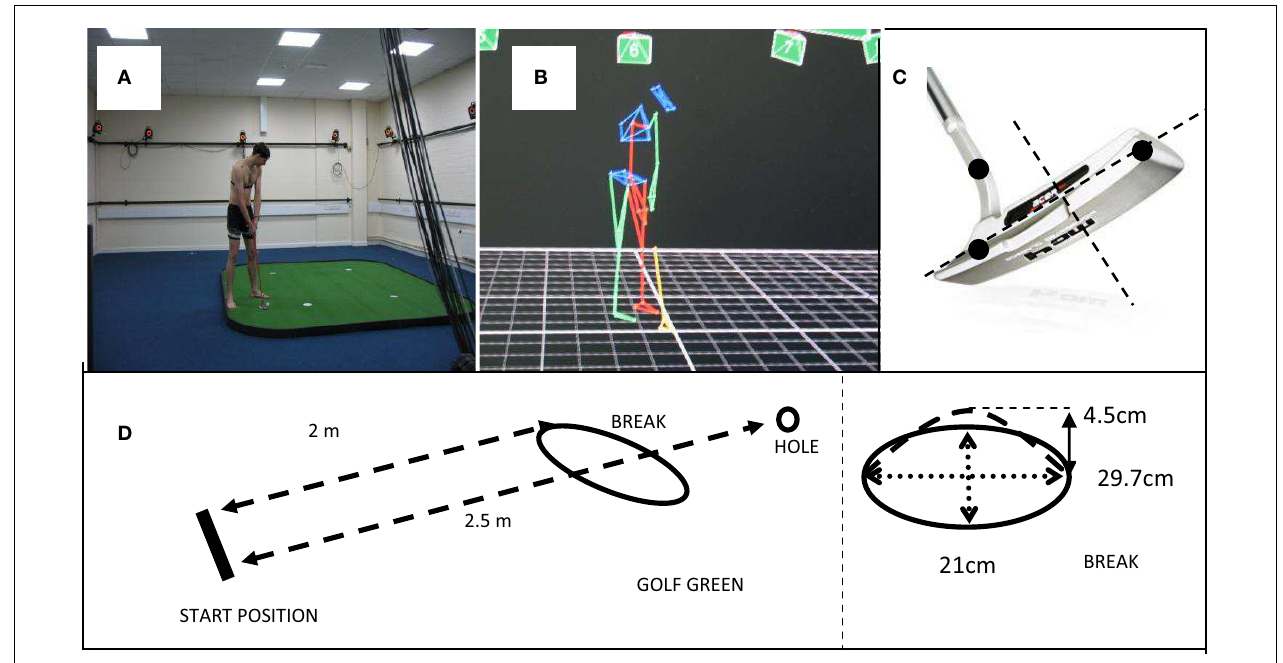
FIGURE 1 | (A) Twelve cameraVicon system and putting surface; (B) example screen shot of Nexus software; (C) retro-reflective marker placement on club-head; (D) schematic of the putting set up and breaker